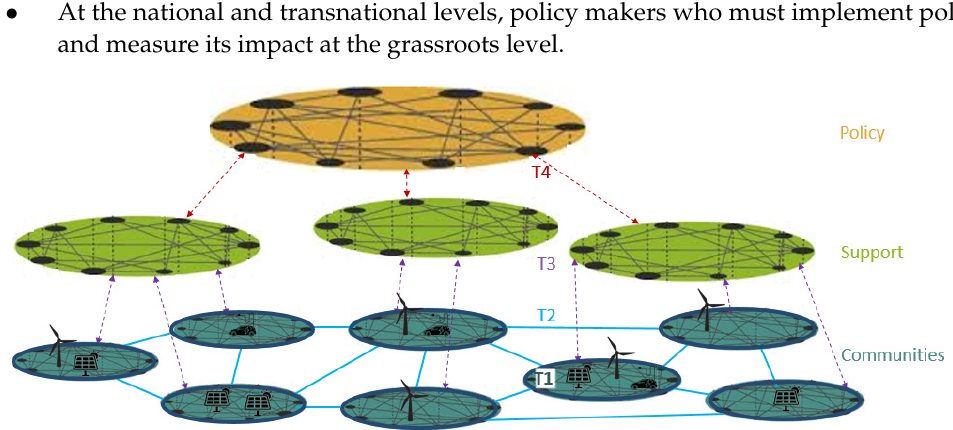
Figure 1. OSS design architecture. T1–T4 indicate the transactions between users